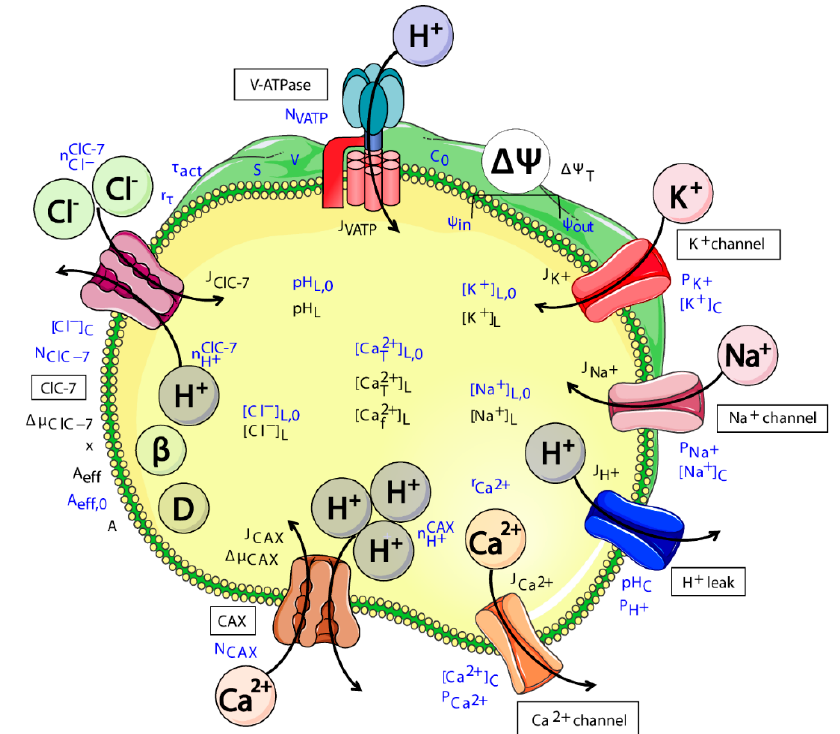
Figure 1. Schematic representation of all components included in the model of ion homeostasis. The V-ATPase pumps protons (H + ) into the lysosomal lumen for acidification. ClC-7 antiporter transports chloride ions (Cl − ) in exchange for protons. CAX transports calcium ions (Ca 2 + ) in exchange for protons. Proton (H + ), potassium (K + ), sodium (Na + ) and Ca 2 + channels allow the passive movement of these ions. The Donnan particles (D) a ff ect lysosomal acidification through the membrane potential, and bu ff ering capacity ( β ) of the lumen a ff ects the rate of pH changes. The names of the channels and transporters are indicated with labels. Variables and parameters are written in blue and black, respectively. The flux across the membrane irrespective of direction is represented by black arrows. The cartoon was created using Servier Medical Art templates (https: // smart.servier.com), which are